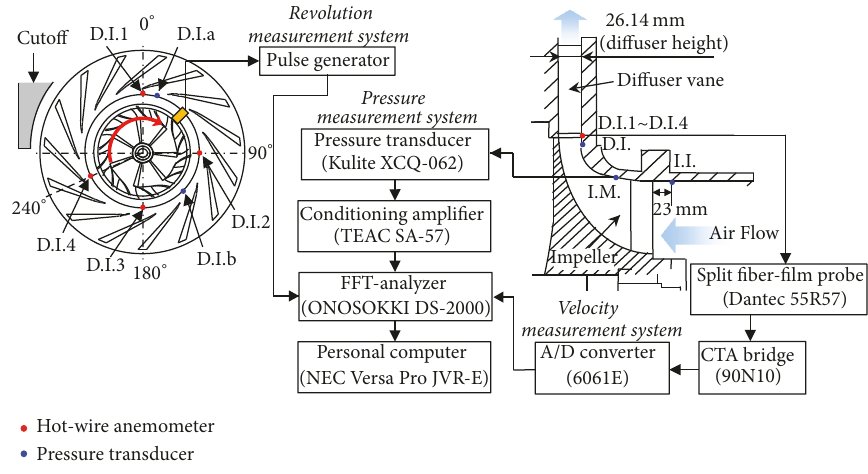
Figure 1: Experimental apparatus and measuring system.